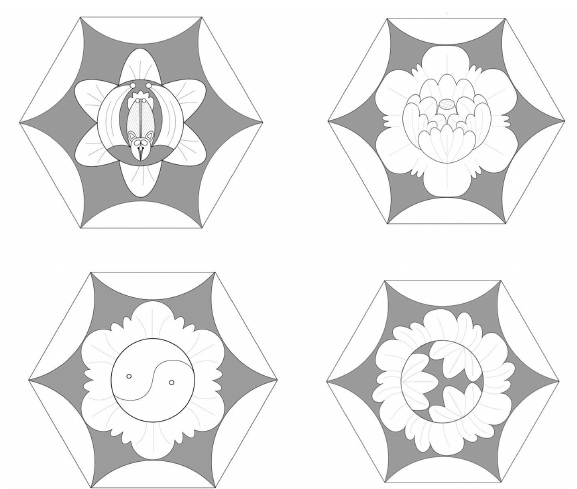
Figure 10. Different Peony Sculptures in the Brick Carving of Hongshuiquan Mosque of Qinghai province (by Gou Lanxi, 2018). The screen wall of this mosque has 255 different peony sculptures. In these four examples, we can see different flower hearts as bat, the Taiji Diagram, blooming, and half-blooming